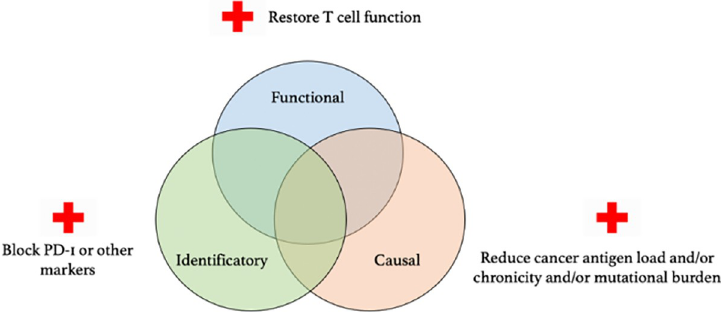
Fig 3. Targeting “exhaustion” in cancer therapies means different things depending on the approach to immunological exhaustion one adopts. PD-1, programmed cell death protein 1.